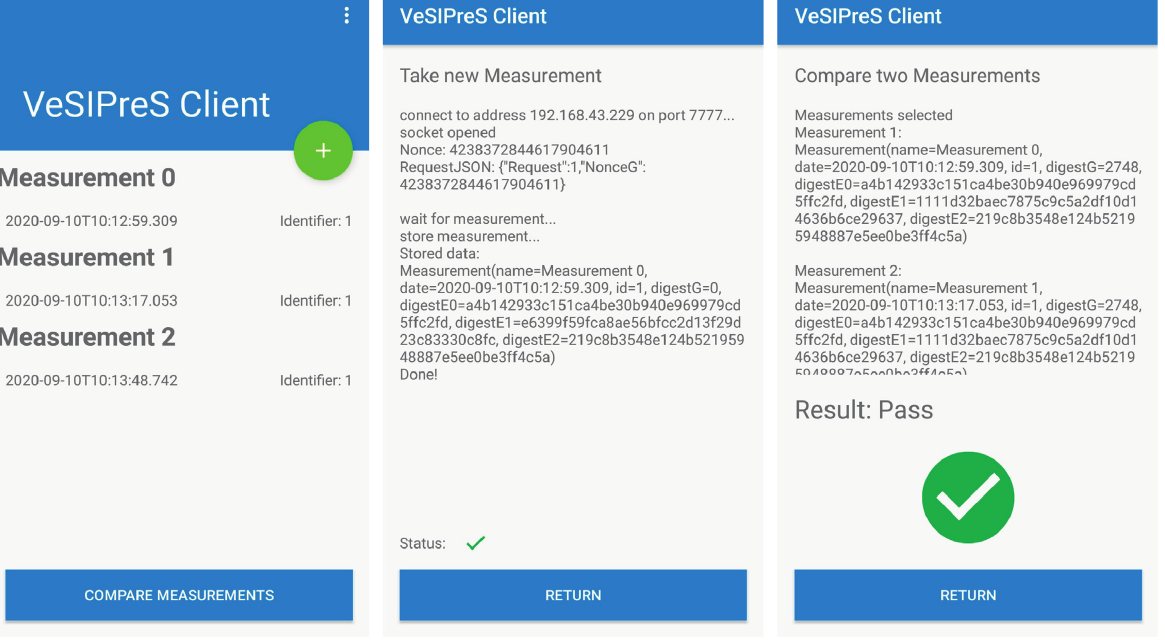
Figure 10: Screenshots from the user application with the main functions (from left to right: main screen with the possibilities to take a new measurement and compare two measurements, taking a new measurement, comparing the two